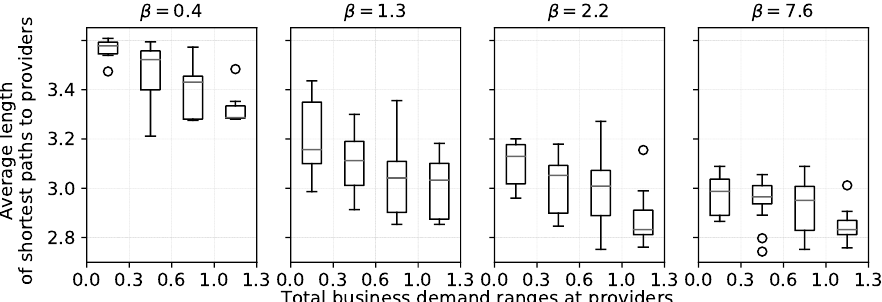
Figure 4. Average length of paths to providers by the amount of service